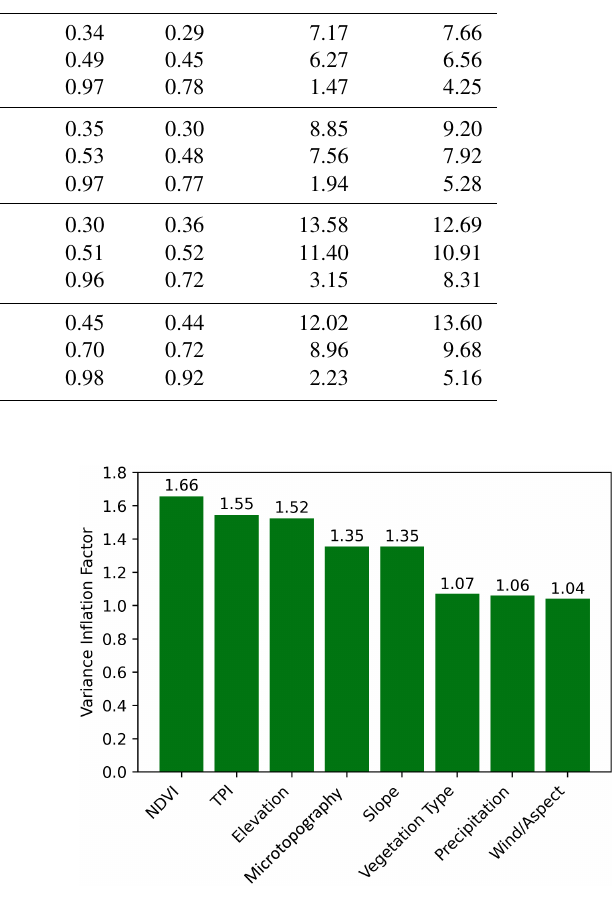
Figure 6. Variance inflation factors for the model